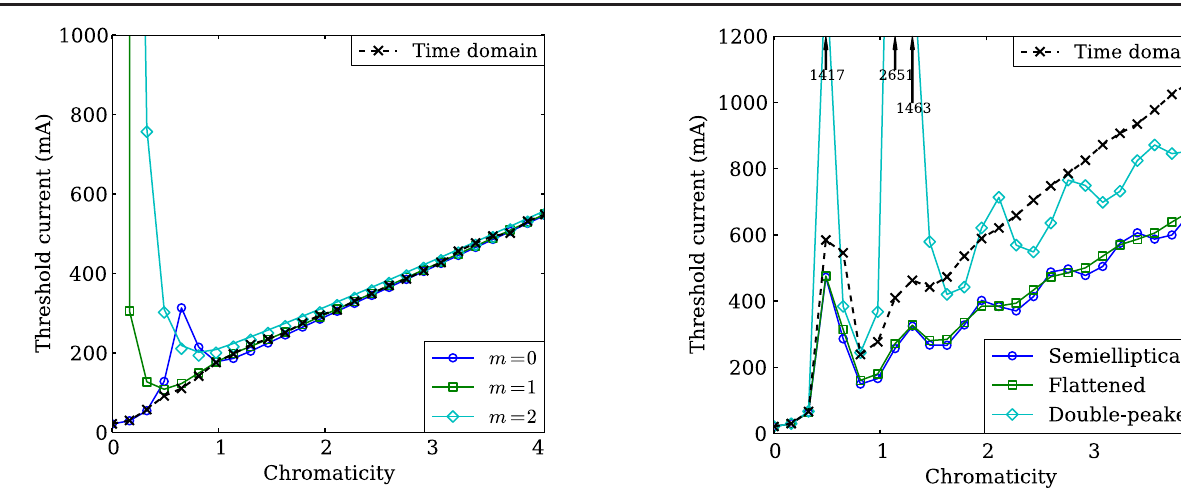
FIG. 5. Threshold current for the coupled-bunch resistive-wall instability for the case with a harmonic cavity flat potential. Results of macroparticle simulations (dashed line) in the time domain are compared with those obtained using a frequency domain computation of the m ¼ 0 head-tail mode for three non- Gaussian distributions (solid